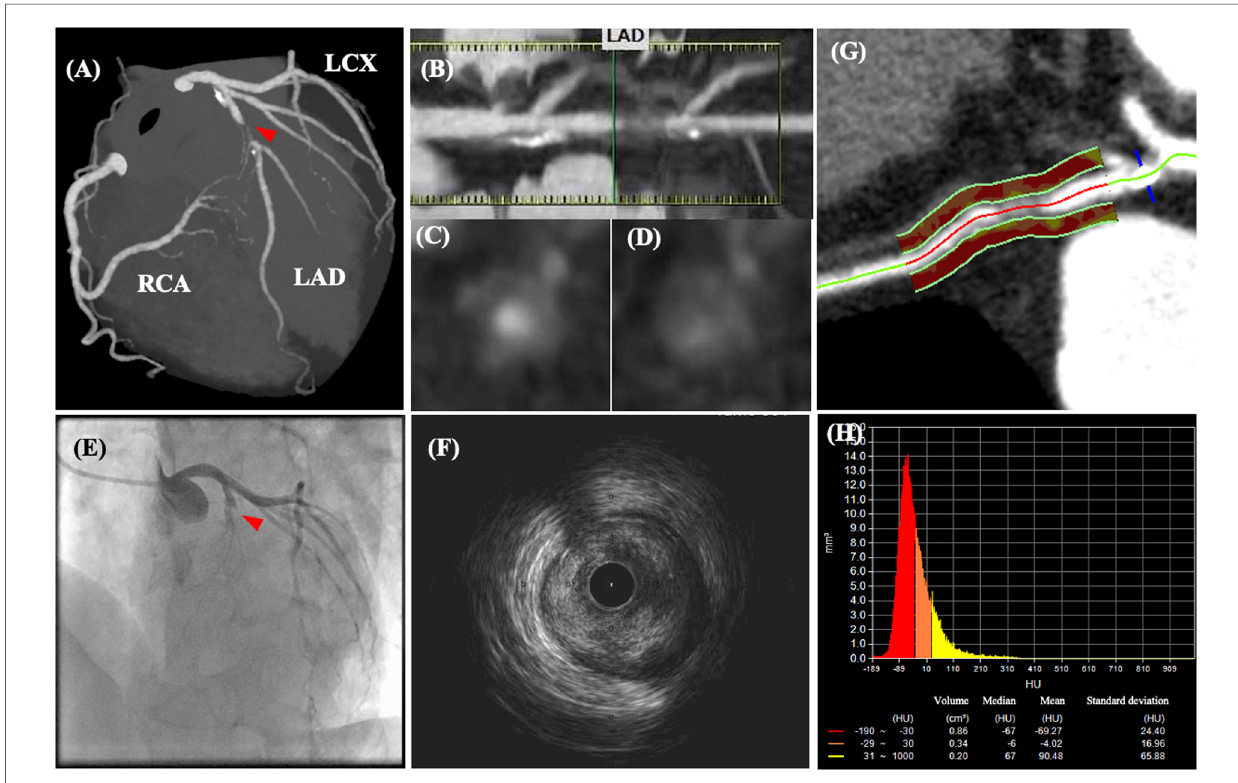
FIGURE 3 Coronary computed tomography angiography and angiographic images of a patient with acute chest pain. CCTA images of a patient with acute chest pain without ST-segment changes on electrocardiography. CCTA images ( A – D ) indicate 70 – 99% luminal stenosis with high-risk plaque features (positive remodeling, low-attenuation plaque, napkin ring sign, and spotty calci fi cation) in the proximal left ascending coronary artery (LAD). After CCTA examination, the patient ’ s chest pain worsened, and ST-segment elevation was detected. ( E ) Emergent coronary angiography revealed total occlusion of the LAD, which corresponded to the location of the high-risk plaque visualized on CCTA. ( F ) Intravascular ultrasonography revealed an intraluminal thrombus secondary to plaque rupture. ( G,H ) Post-hoc analysis demonstrated an increased pericoronary artery attenuation of > − 70 HU. Modi fi ed from reference